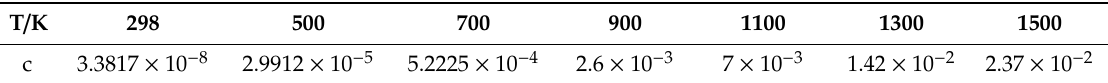
Table 2. Solubility of carbon in titanium alloy under di ff erent